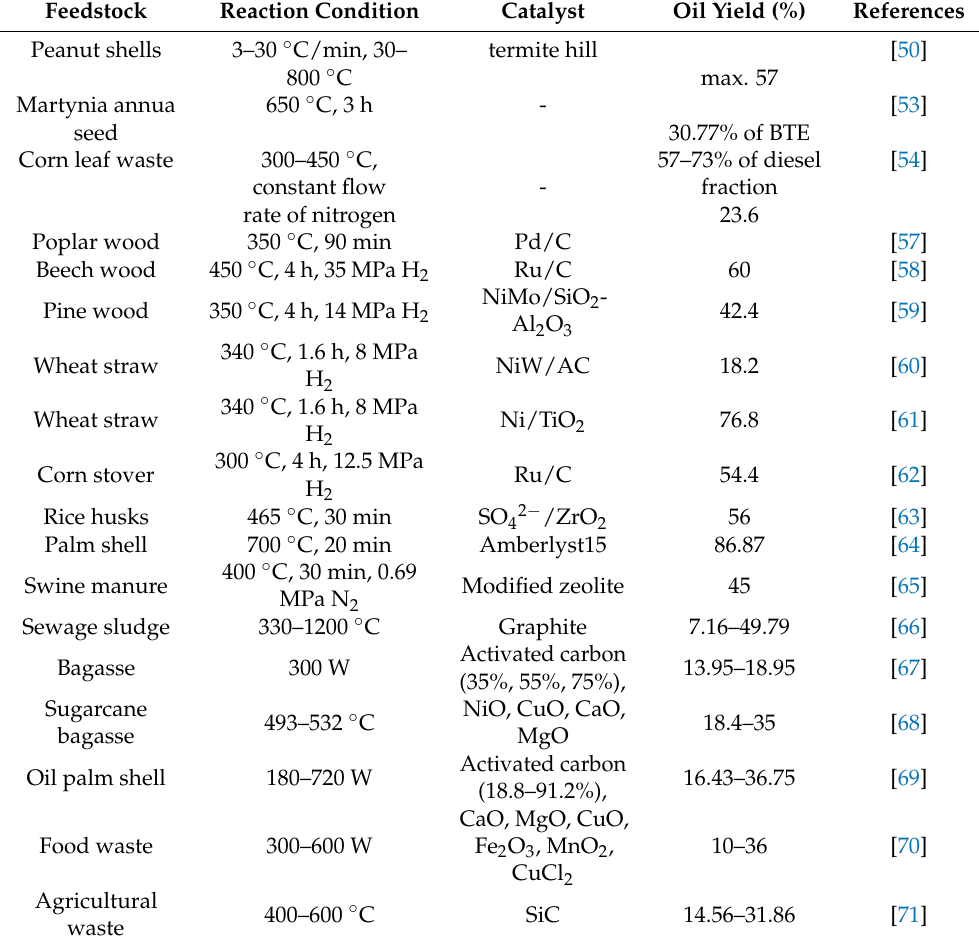
Table 3. Properties of bio-oil obtained by different upgrading methods.